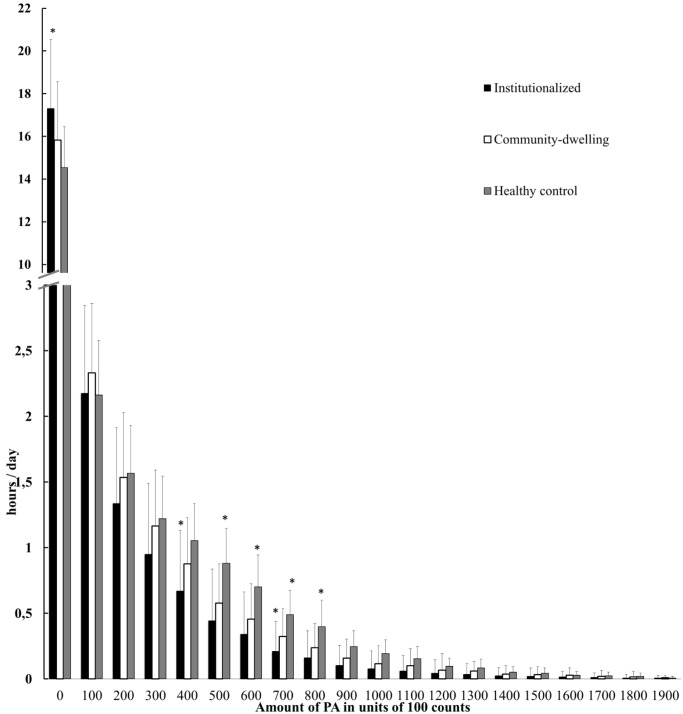
Quantity of physical activity (PA) as inferred from the time spent in specific activity count zones.PA counts were binned in units of 100 counts. The first bars show the daily hours spent in sedentary time (0–99 counts). Note the axis interruption that highlights the large number of hours spent in sedentary time vs. other activity counts zones. Filled bars: dementia patients living in an institution. Open bars: community-dwelling dementia patients. Gray bars: community-dwelling healthy older adults. Values are mean (and standard deviation). *, different to community-dwelling dementia patients (p < 0.05).